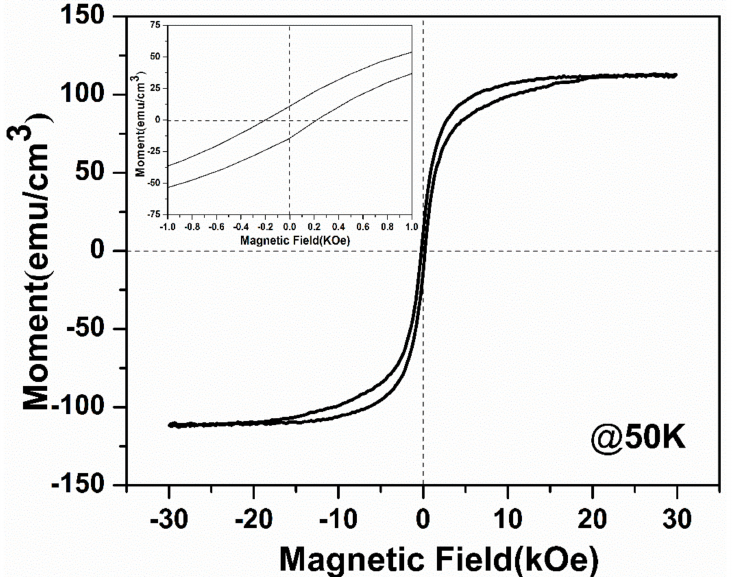
Figure 6. Magnetic hysteresis loop of the micro-patterned CaMn 7 O 12 ceramic film at 50 K. The inset depicts the partial enlarged view of the M-H loop at near zero magnetic